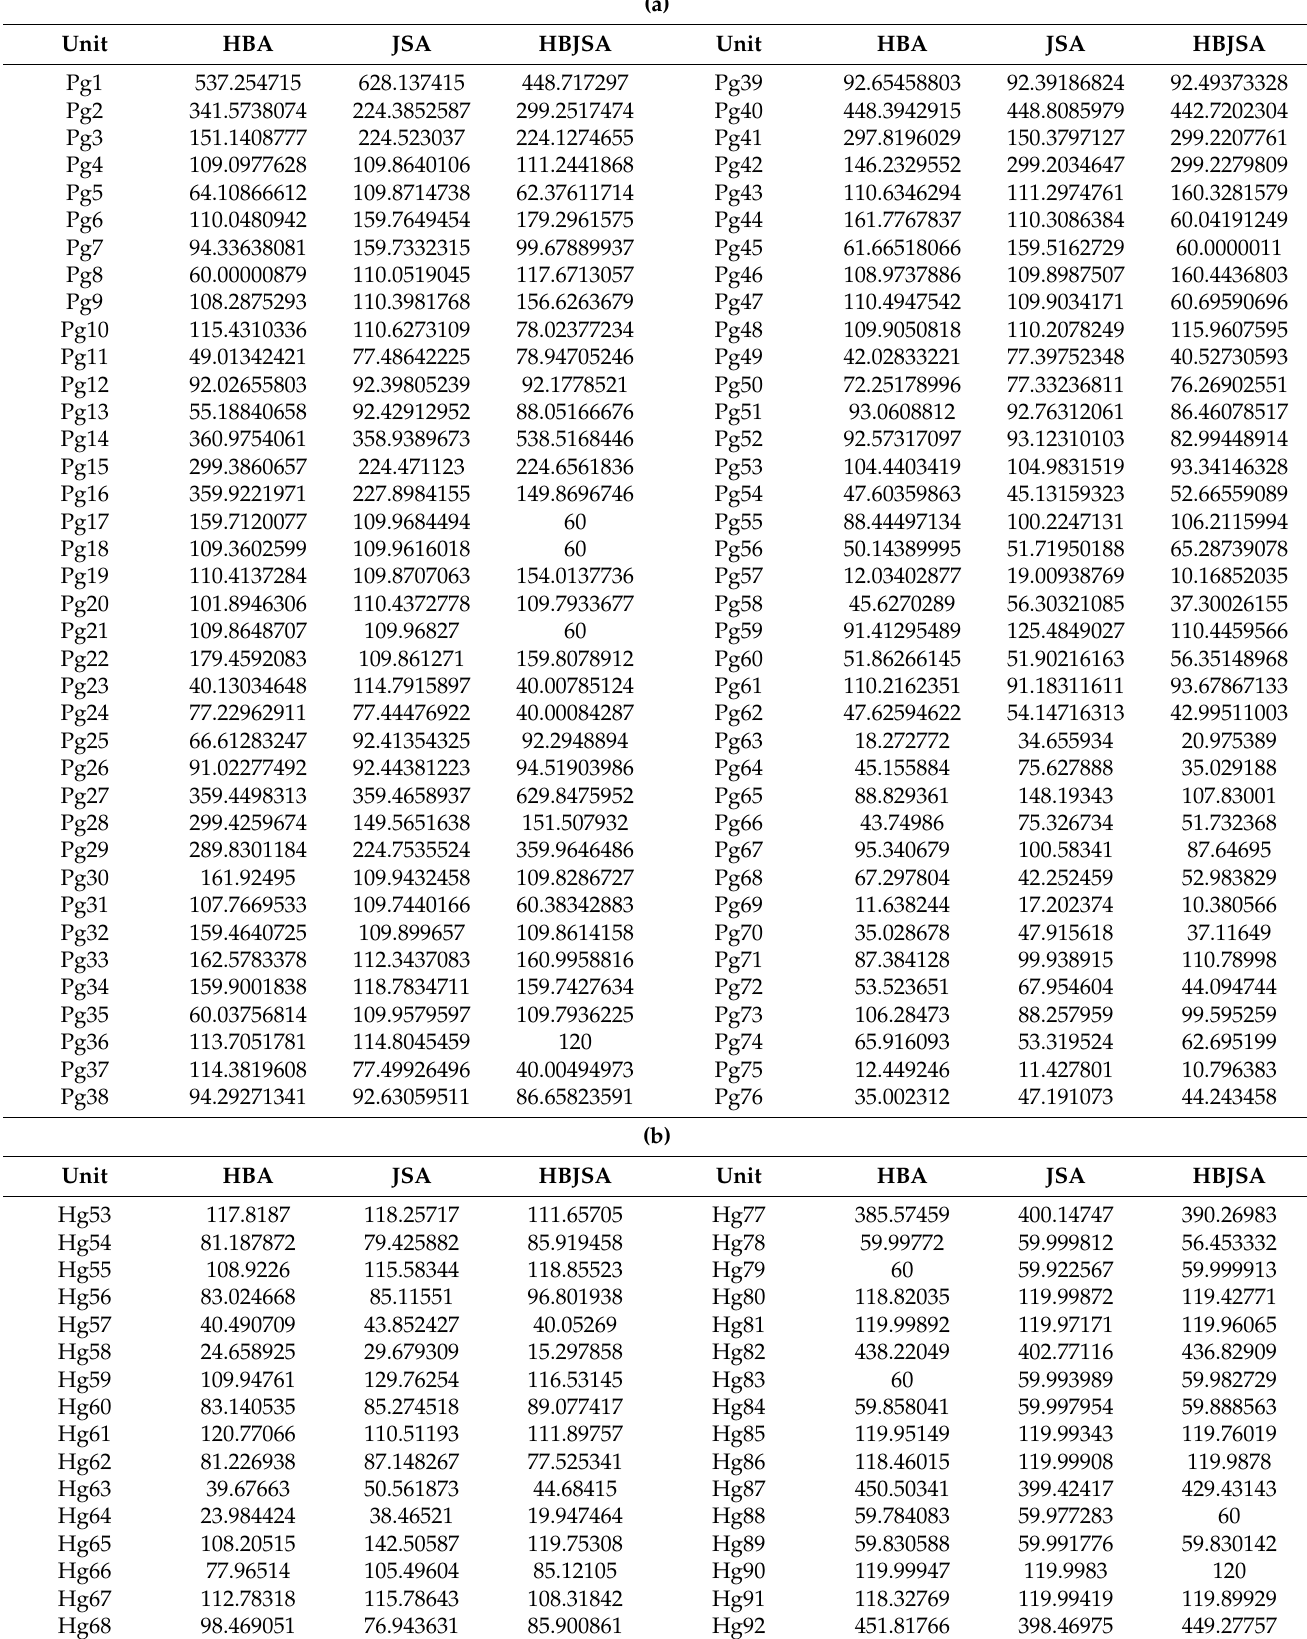
Table 7. Comparison between HBA, JSA, and the proposed HBJSA for the 96-unit test system of CHP economic